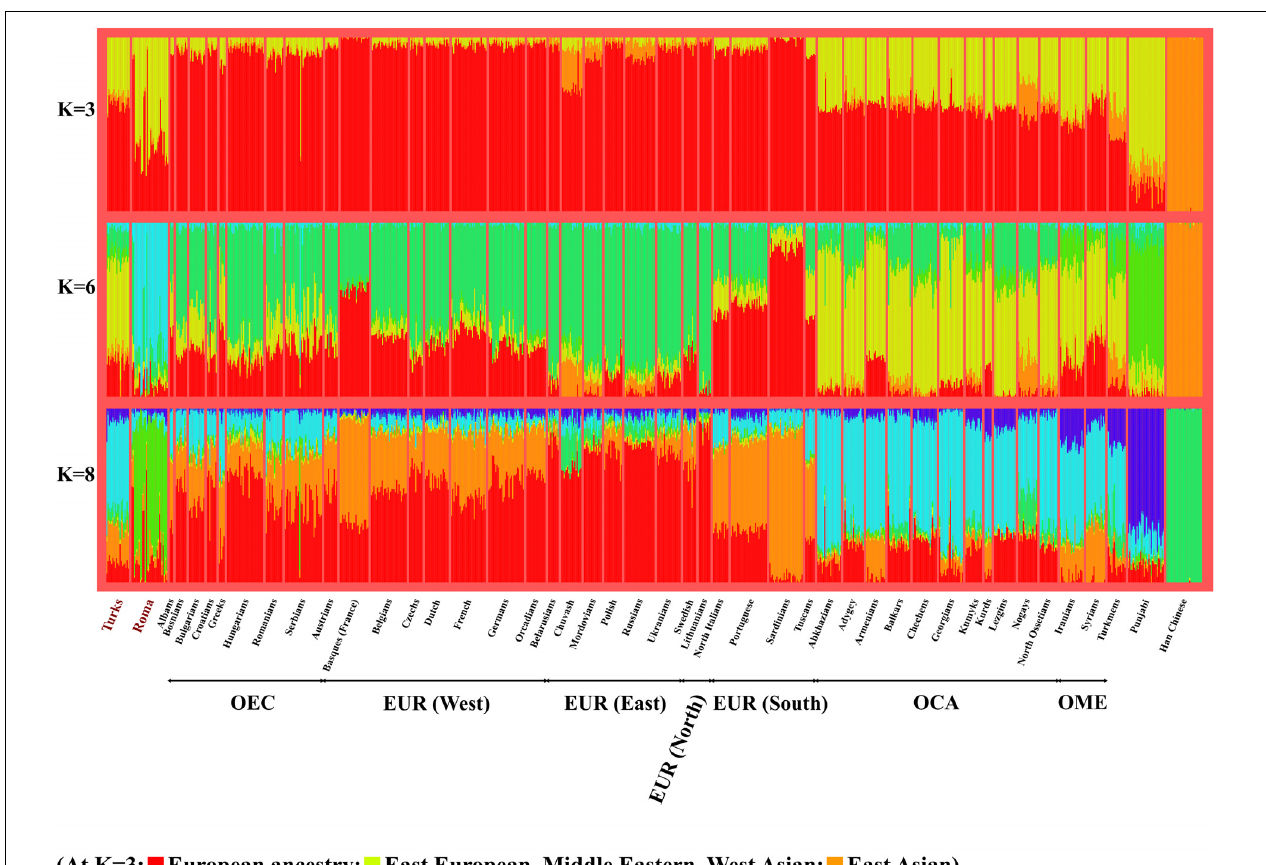
FIGURE 3 | Relationship of Turks and Roma to various Eurasian populations according to ADMIXTURE analysis. ADMIXTURE analysis results with K = 3, 6, and 8 hypothetical ancestral groups. The number of displayed individuals was limited to 30 at each group. ADMIXTURE results with K -values 3–10 can be found in the Supplementary Figure 1